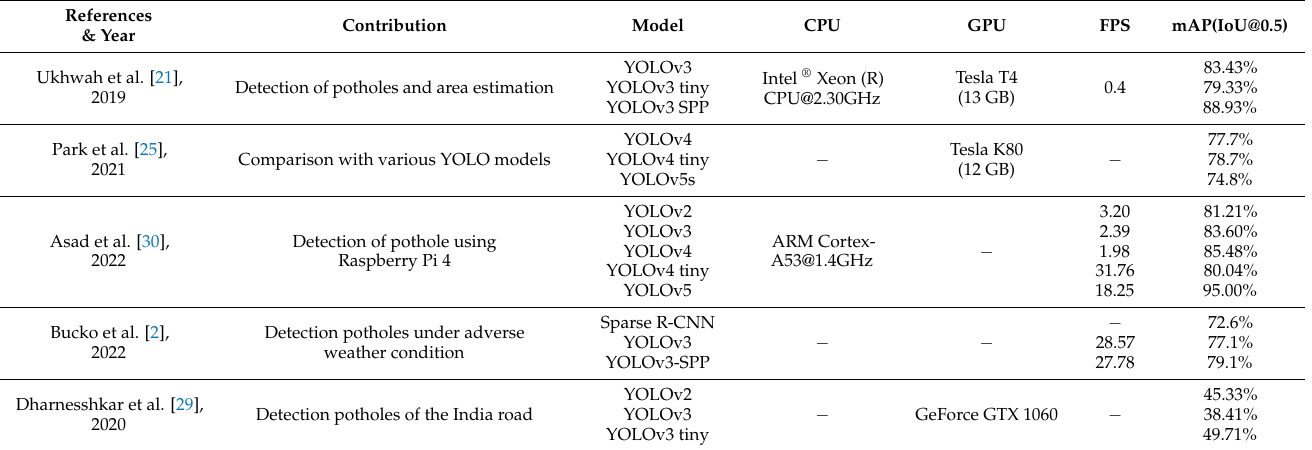
Table 1. A summary of recent road pothole detection algorithm